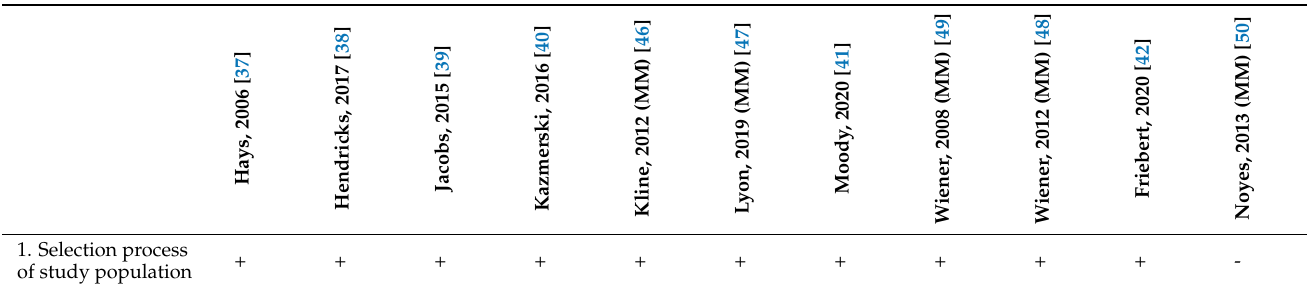
Table A2. Risk of bias assessment observational studies according to an adapted risk of bias assess- ment